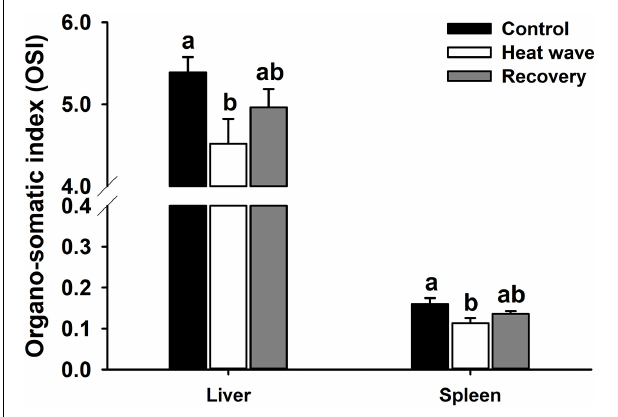
FIGURE 3 | Effects of heat wave on organo-somatic index of Mauremys mutica. Data were represented as mean ± standard error